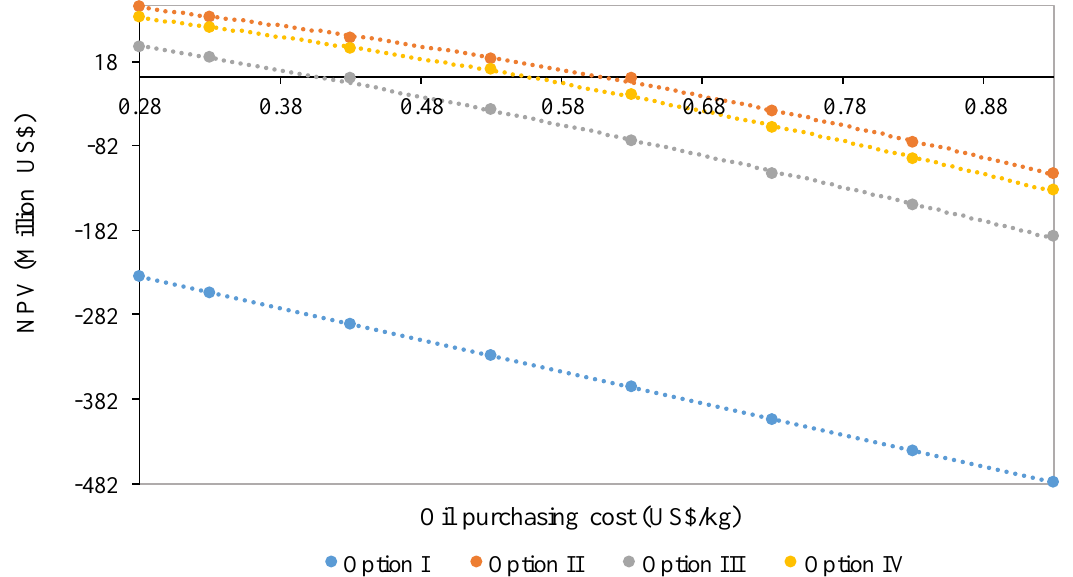
Figure 5. Effect of change of oil purchasing cost on NPV (net present value). Figure 5. E ff ect of change of oil purchasing cost on NPV (net present